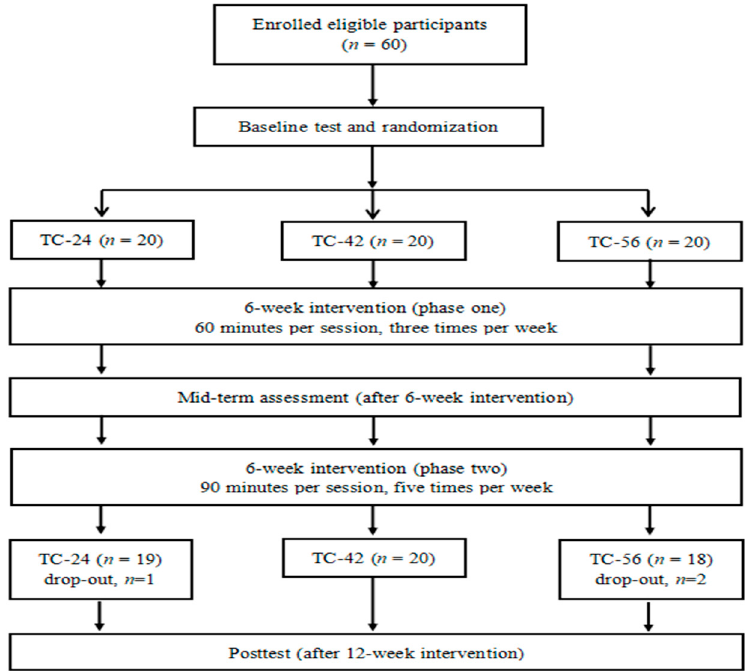
Figure 1. Experimental procedures from recruitment to the end of experimental design.